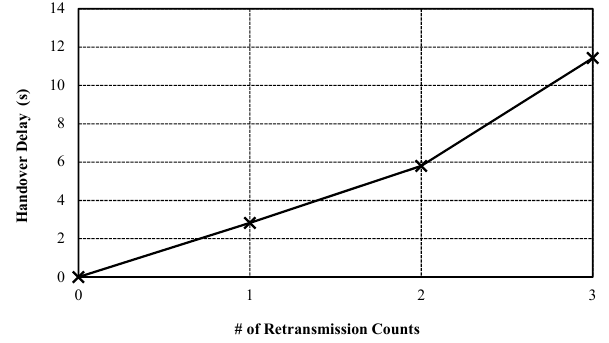
Figure 5. Total handover delay with considering CoAP retransmission mechanism by impact of T r .